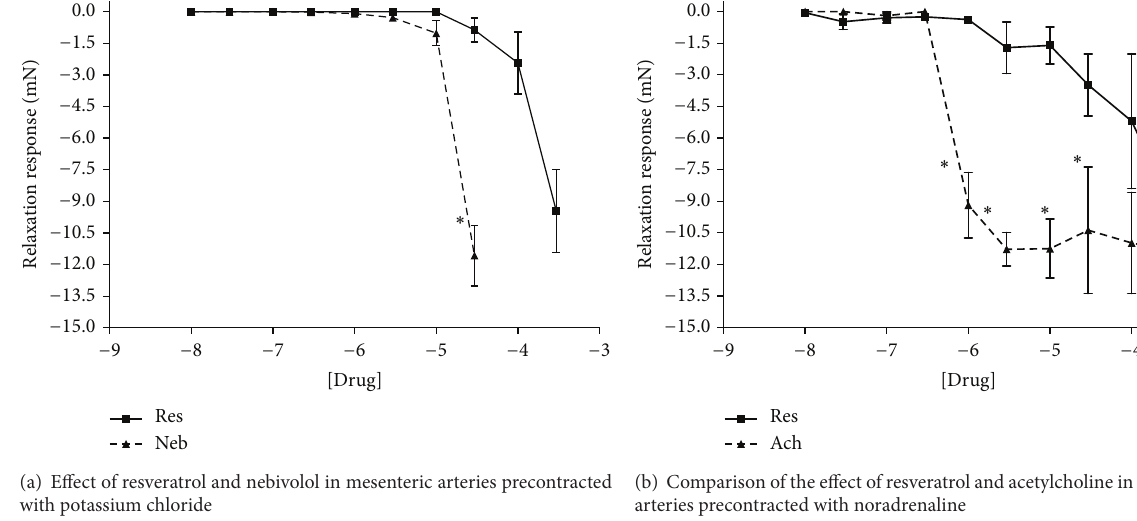
(b) Comparison of the effect of resveratrol and acetylcholine in mesenteric arteries precontracted with noradrenaline